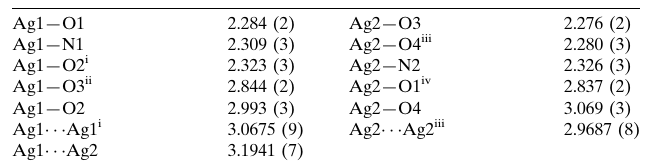
Selected bond lengths (A˚ ).